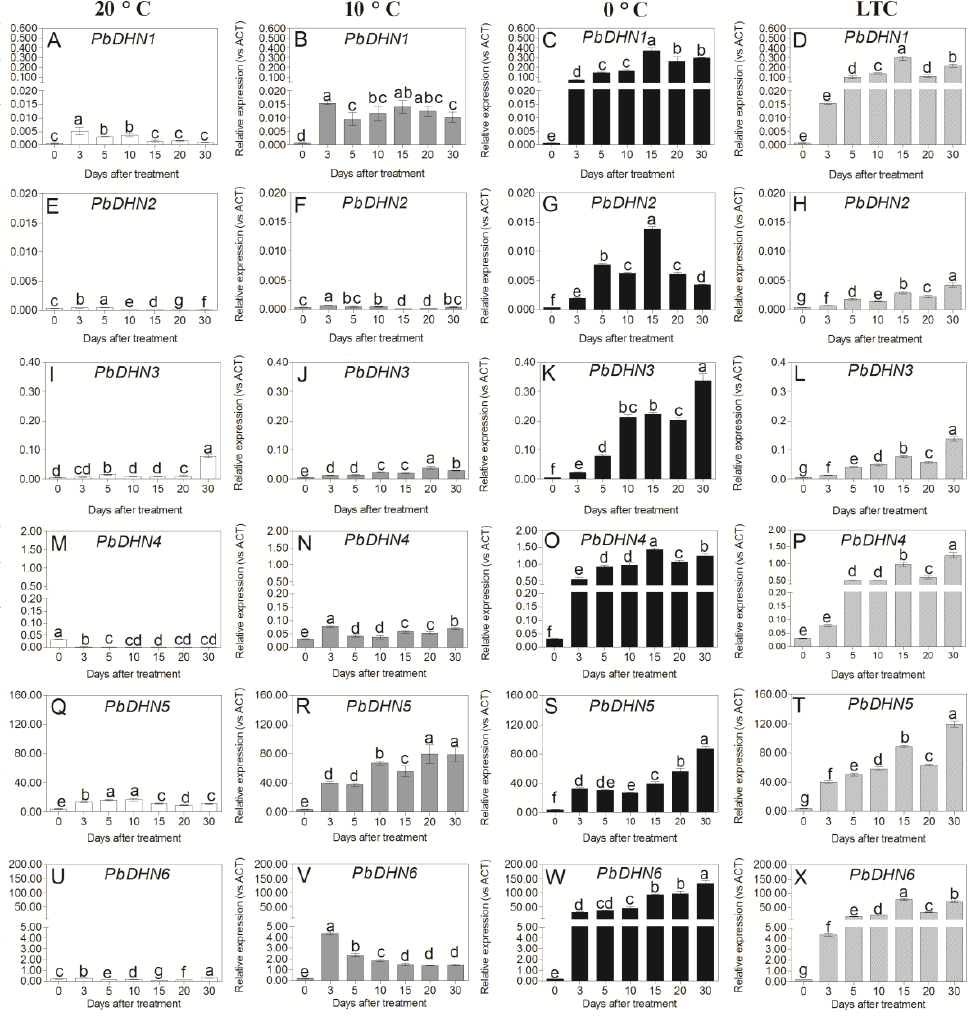
Figure 6. Effects of 20 °C ( A , E , I , M , Q , U ), 10°C ( B , F , J , N , R , V ), 0°C ( C , G , K , O , S , W ) storage and LTC ( D , H , L , P , T , X ) treatments on the expression pattern of PbDHNs in the peel of ‘Huangguan’ pear fruit. Data are means of three biological replicates, and error bars indicate SD. Different letters (a – g) above the bar chart indicated significant differences ( p < 0.05) by Duncan’s multiple comparison test.